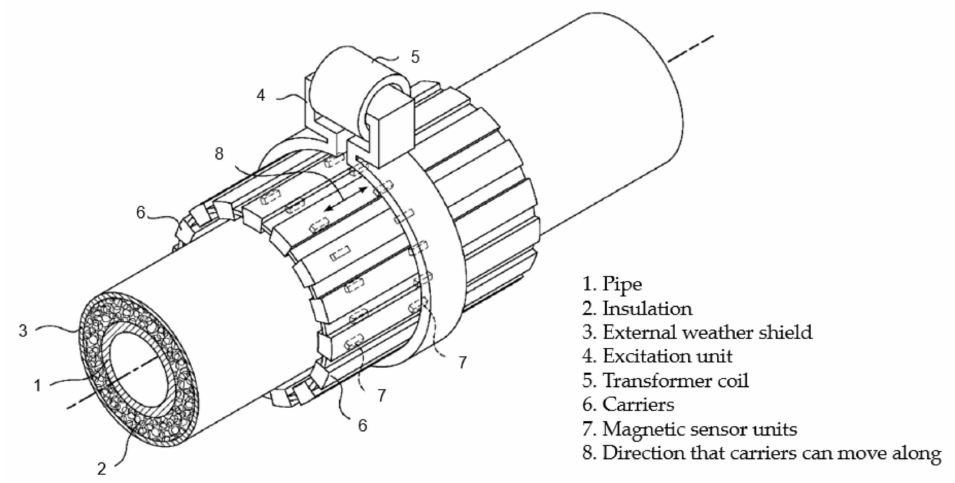
Figure 12. Apparatus sketch for CUI detection equipment that consists of an electrically conductive excitation coil and an electrical power source. Reprinted with authors’ permission from Ref.